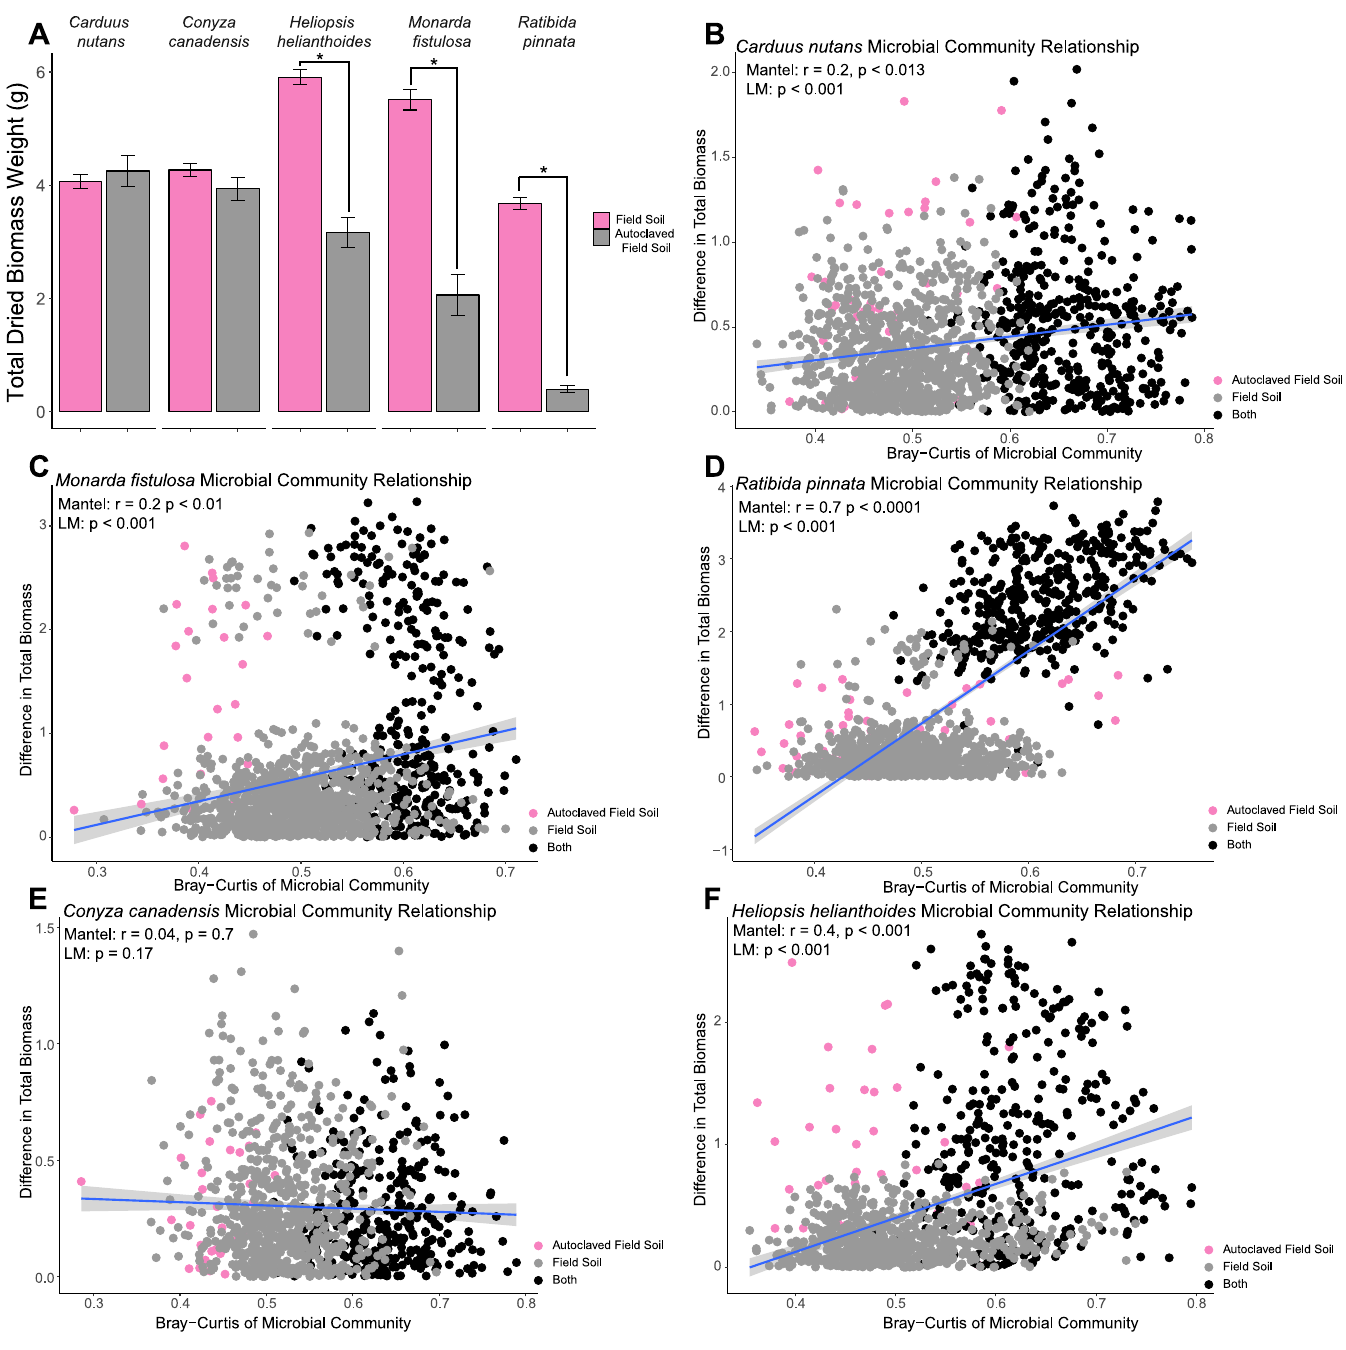
Fig 4. Root-endophytic bacterial community composition as a function of growth differences. (A) Bars represent mean total dried biomass across all field soils and all autoclaved field soils with SE. The asterisks indicate statistically significant differences [ANOVA tests with P � 0.05, n = 537]. Difference in total biomass between individuals of the same plant species correlated with difference in endophytic root microbiome composition (calculated using Bray-Curtis dissimilarity). Each point represents two individuals’ difference in root microbiome and biomass. (B) C . nutans (n = 52), (C) M . fistulosa (n = 52), (D) R . pinnata (n = 50), (E) C . canadensis (n = 46), (F) H . helianthoides (n = 47). Differences calculated between samples grown in autoclaved soil are in grey, between samples grown in field soil are in pink, and between one sample grown in field soil and one grown in autoclaved soil in black. Lines and regression statistics are based on Mantel and linear regression.